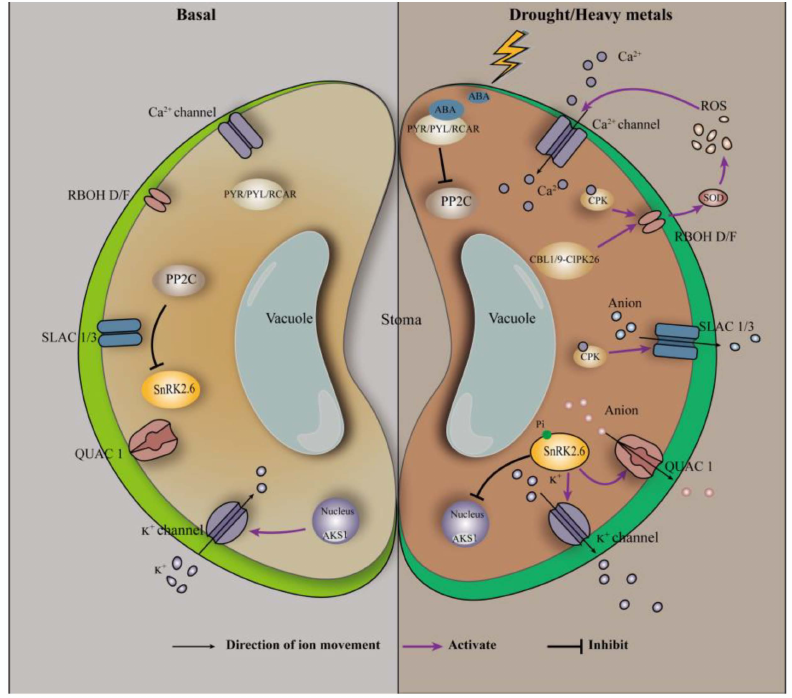
Figure 2. ABA-involved signal transduction in the guard cells. Adapted from Hauser, et al.